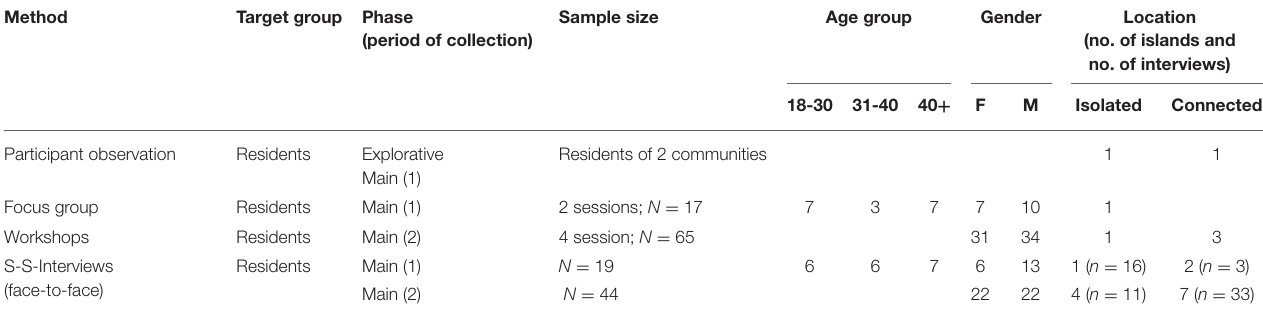
TABLE 1 | Overview of applied